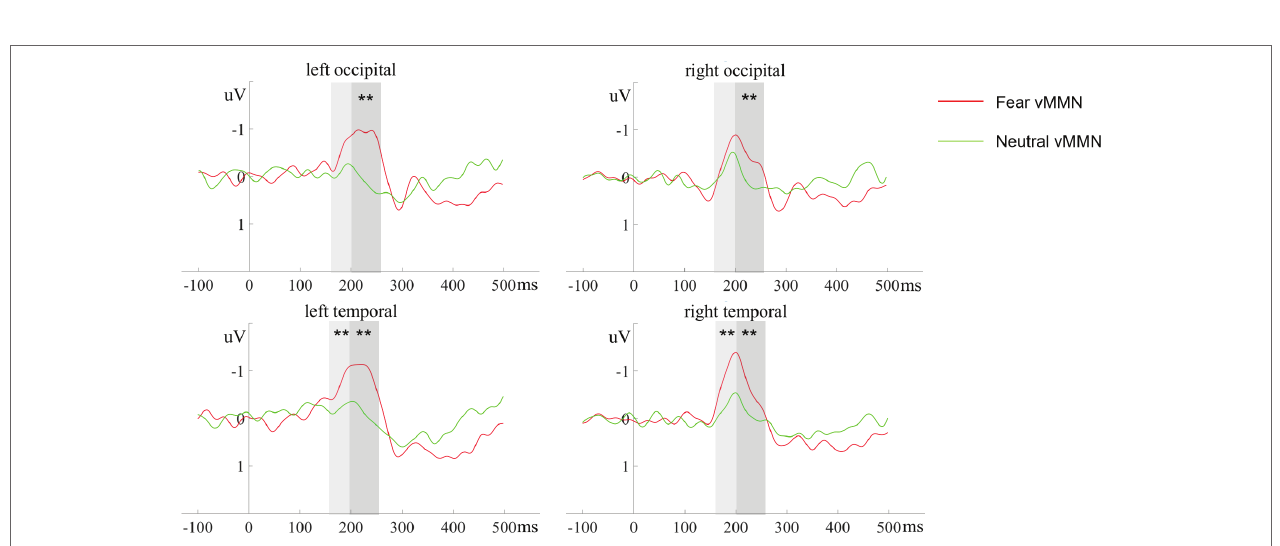
FIGURE 3 | The grand-average ERPs at O1, O2, P7, and P8 evoked by devFear (red line) and devNeutral(green line). ** p < 0.01. The P1 was equal following fearful as compared to neutral deviants. The shaded area indicates the statistical analysis time window of the P1 and the